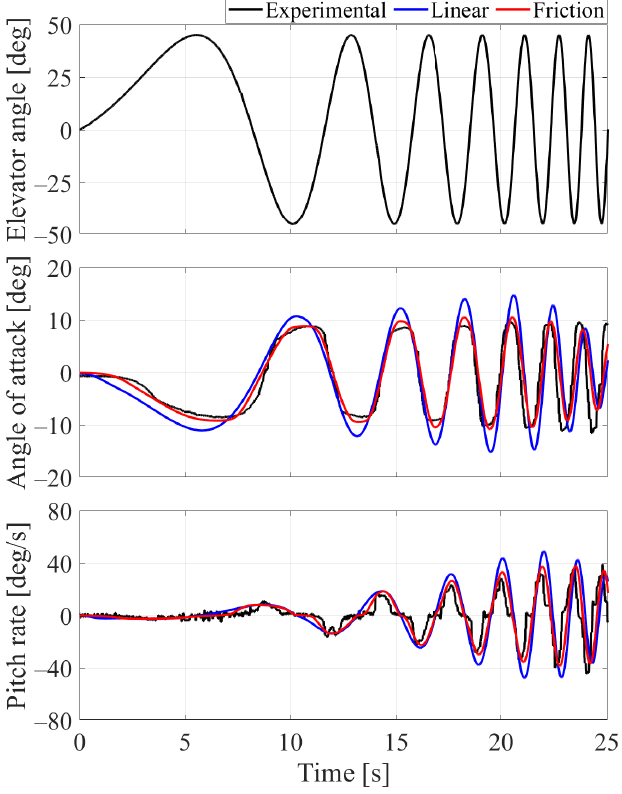
Figure 2. Elevator command ( top ) and related angle of attack ( middle ) and pitch rate ( bottom ) responses. The wind speed was 14 m/s